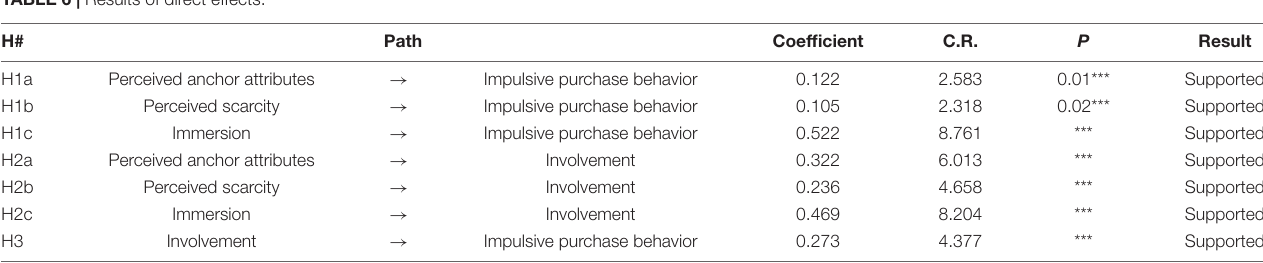
TABLE 6 | Results of direct effects.